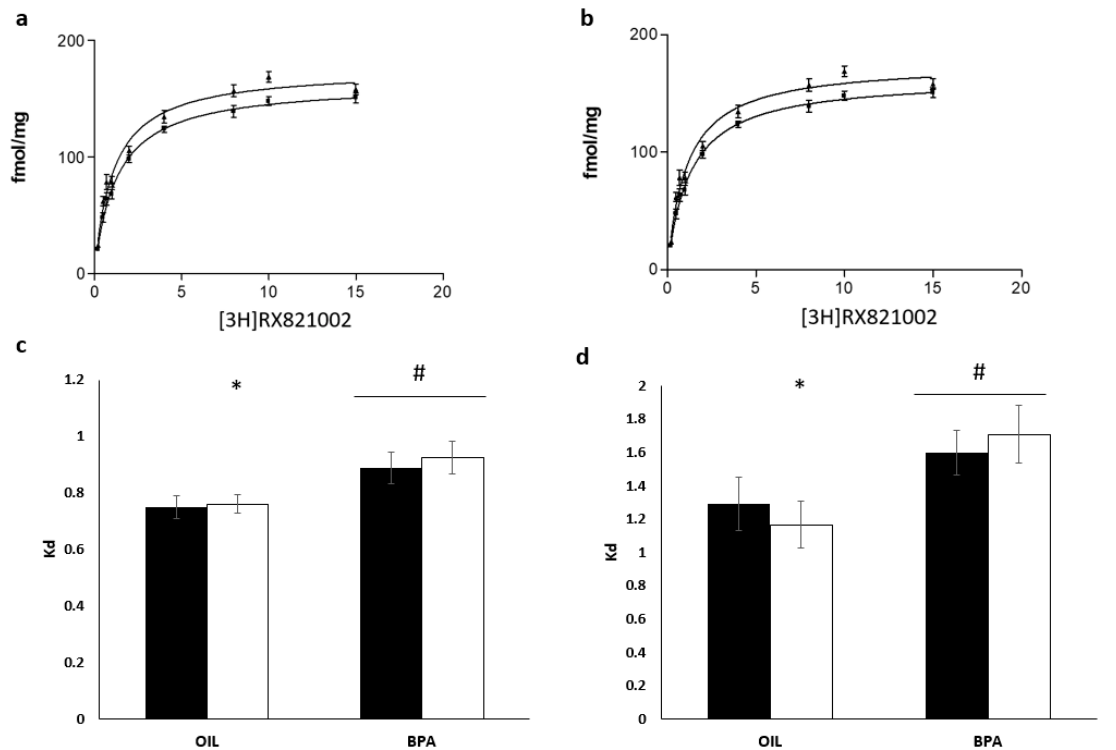
Figure 3. Effects of prenatal exposure to BPA on alpha 2 adrenergic receptor affinity in the locus coeruleus and preoptic area. Binding curves for preoptic area of control ( a ) and BPA ( b ) groups. ( c ) Affinity (Kd) in the locus coeruleus; ( d ) affinity in the preoptic area. (OIL: eight males and eight females; BPA: eight males and seven females). Dark columns = males. * p < 0.05 OIL females vs. BPA females; # p < 0.05 BPA vs. OIL. Data are presented as mean ± SE. POA = preoptic area.